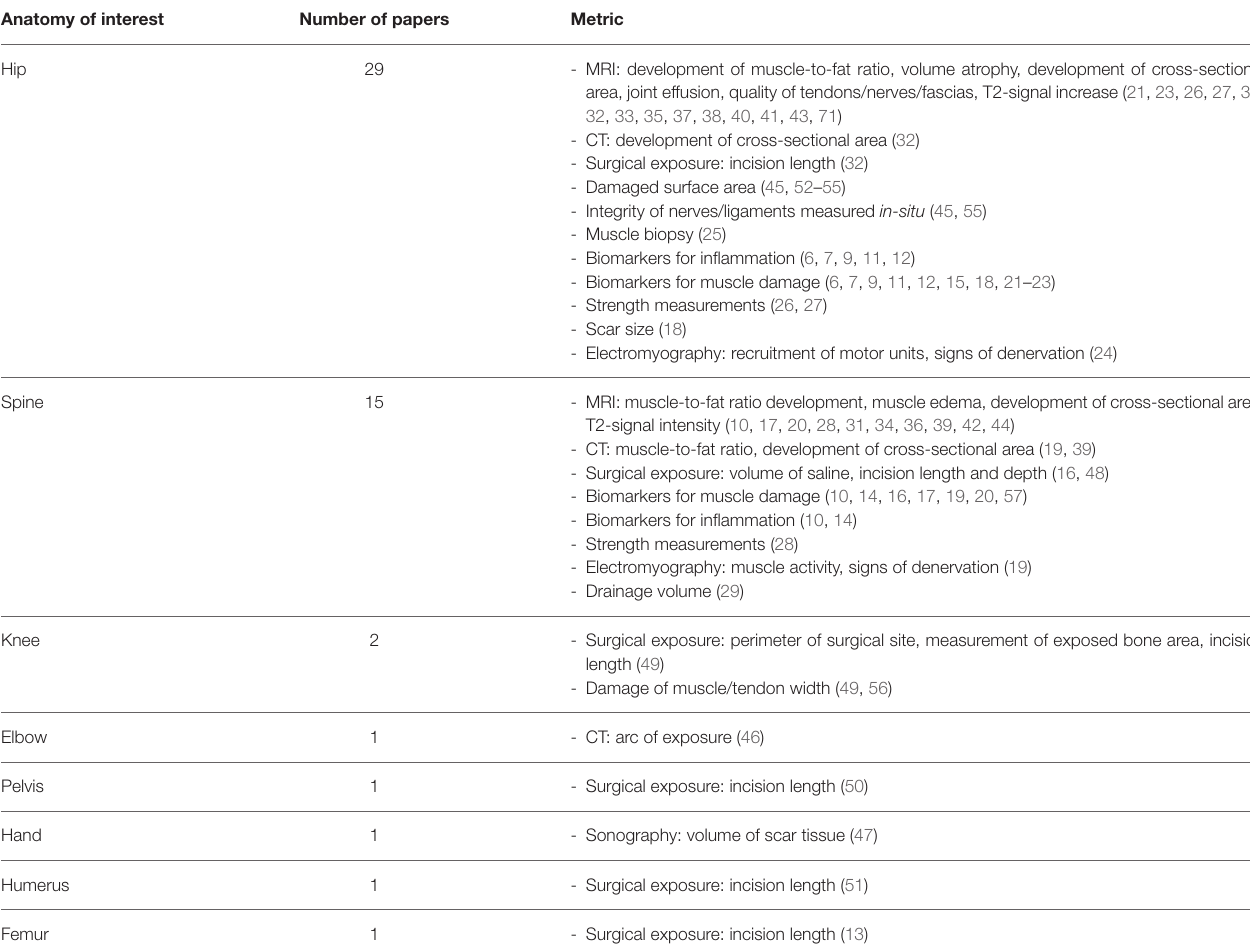
TABLE 3 | A breakdown of the reviewed metrics based on the underlying